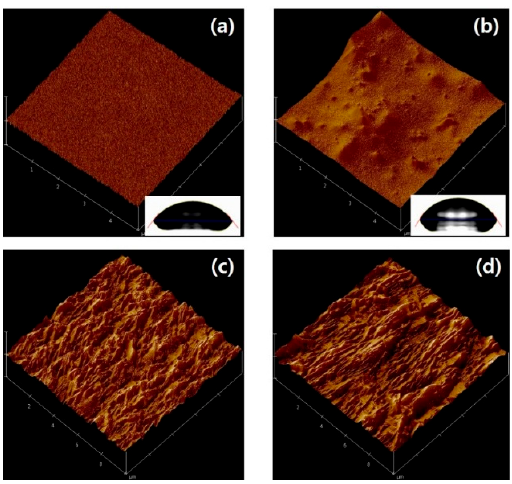
Figure 3. AFM images of the ( a ) c-PVP and ( b ) c-PVP/Y 2 O 3 composite films. The insets show the contact angles on both films. AFM images of the TIPS-pentacene films deposited on the ( c ) c-PVP and ( d ) c-PVP/Y 2 O 3 composite films.